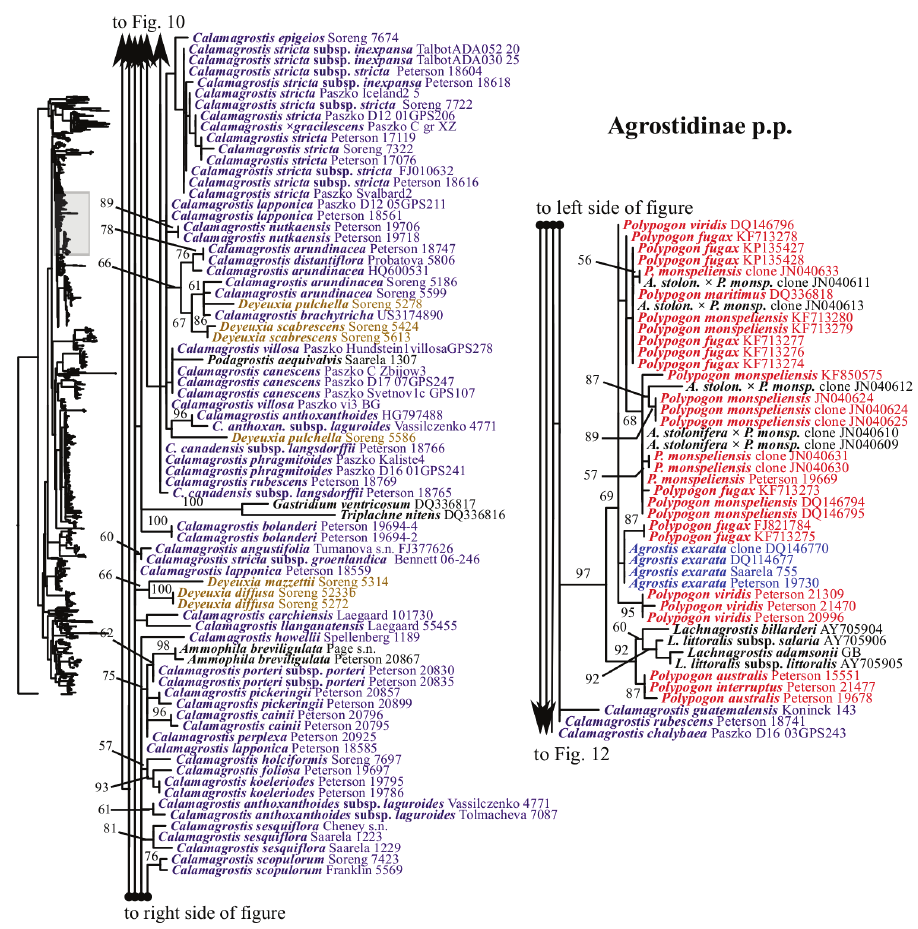
Figure 11. A portion (part of Agrostidinae p.p.) of the maximum likelihood phylogram inferred from ITS data. ML bootstrap support is recorded along branches when >50%. The shaded area of the smaller tree on the left indicates the location in the overall tree of the portion